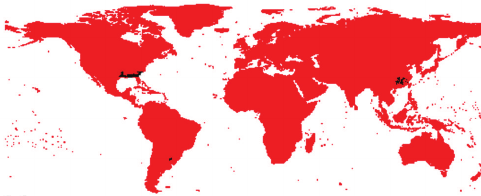
Figure 1: Climatically similar areas to the Lower Coastal Plain are shown in